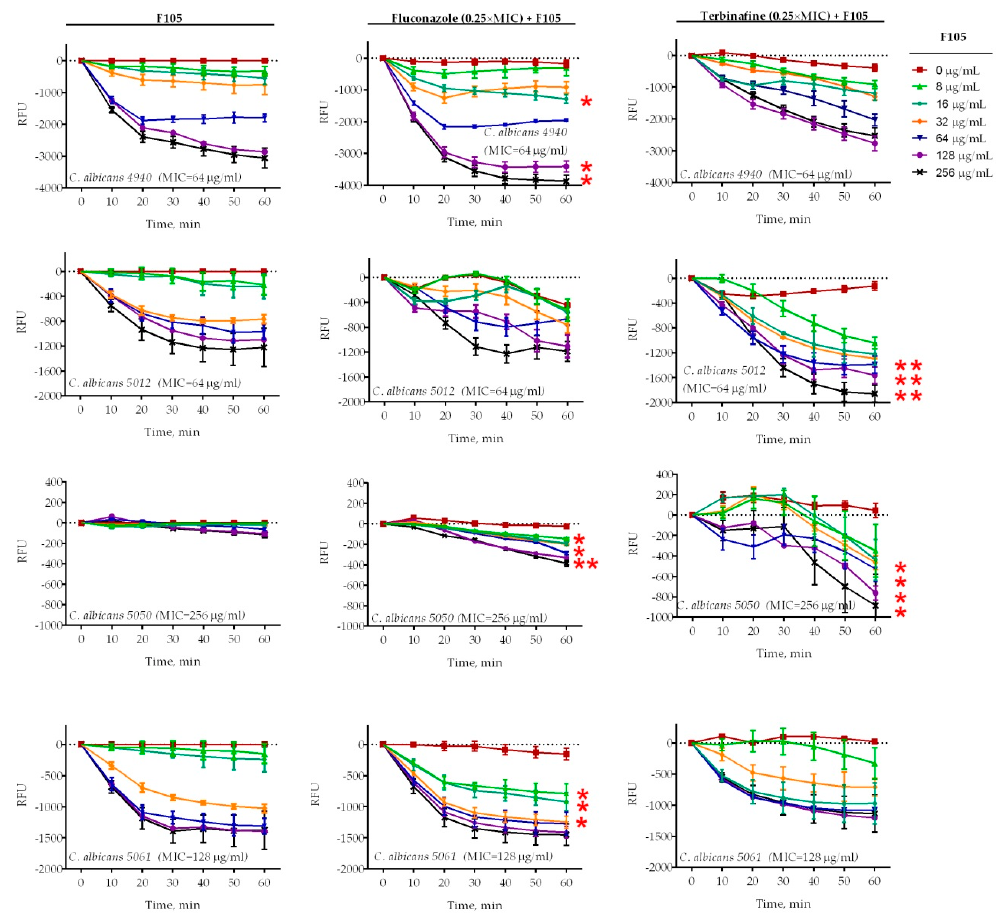
Figure 4. Relative membrane potentials of C. albicans isolates after treatment with various concentrations of F105 and 0.25 × MIC of fluconazole or terbinafine (see Table 1 for MIC values). C. albicans cells in the late exponential growth phase were harvested, washed with PBS, and resuspended in PBS supplemented with 10 μ M DioC 2 (3). After 30 min preincubation, compounds were added as indicated and the fluorescence was measured for 60 min with 10 minute intervals. Lines represent the median values with IQRs from five independent measurements. In cases marked with *, the measured relative fluorescence units (RFUs) after 60 min of exposure were significantly lower in the presence of F105 compared to similar treatments in the absence of F105 according to the Kruskal–Wallis statistical test at p < 0.05. Corresponding MICs for F105 are given in parentheses after the strain names.